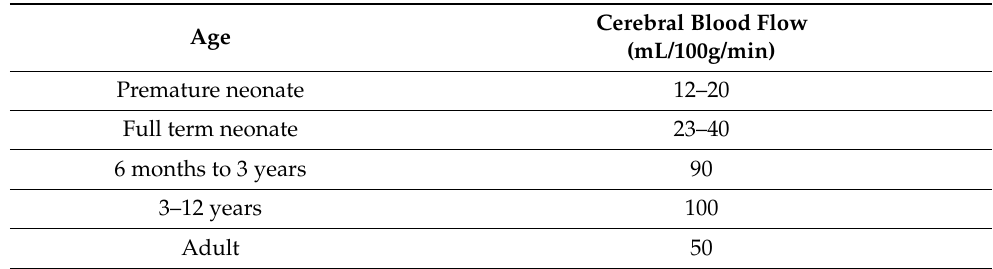
Table 1. Cerebral blood flow for different age groups